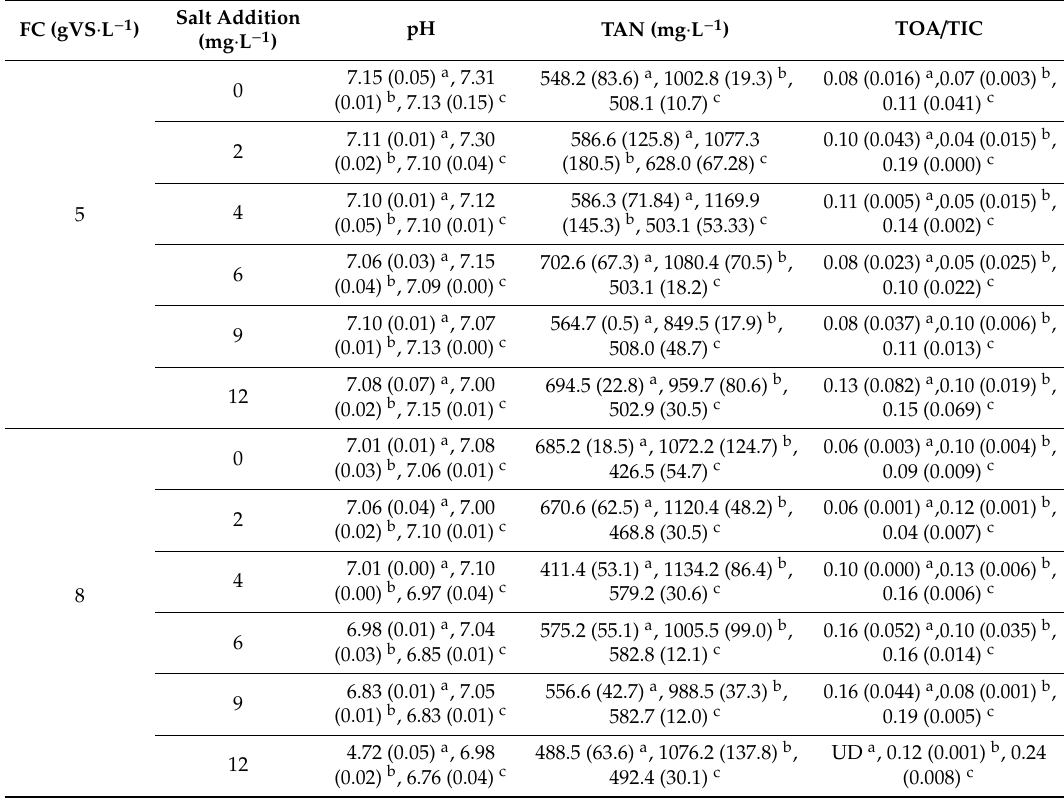
Table 4. Characteristic of digestates with di ff erent levels of salt